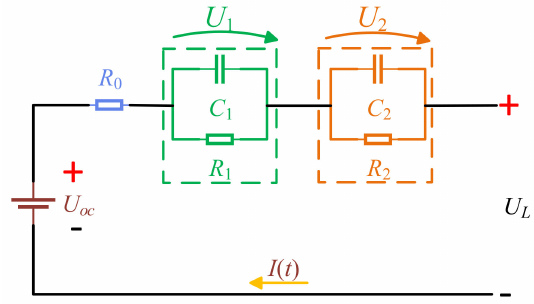
Figure 2. The second-order resistor–capacitor equivalent circuit